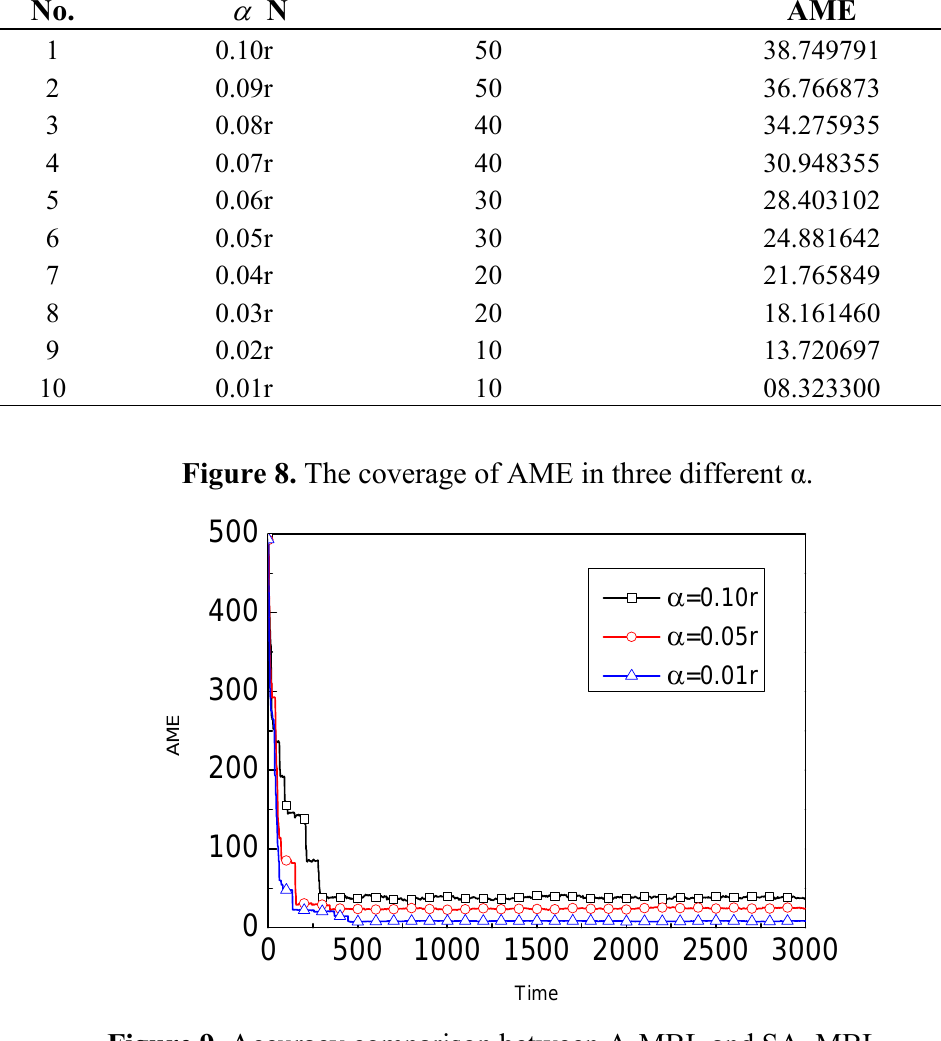
Figure 9. Accuracy comparison between A-MBL and